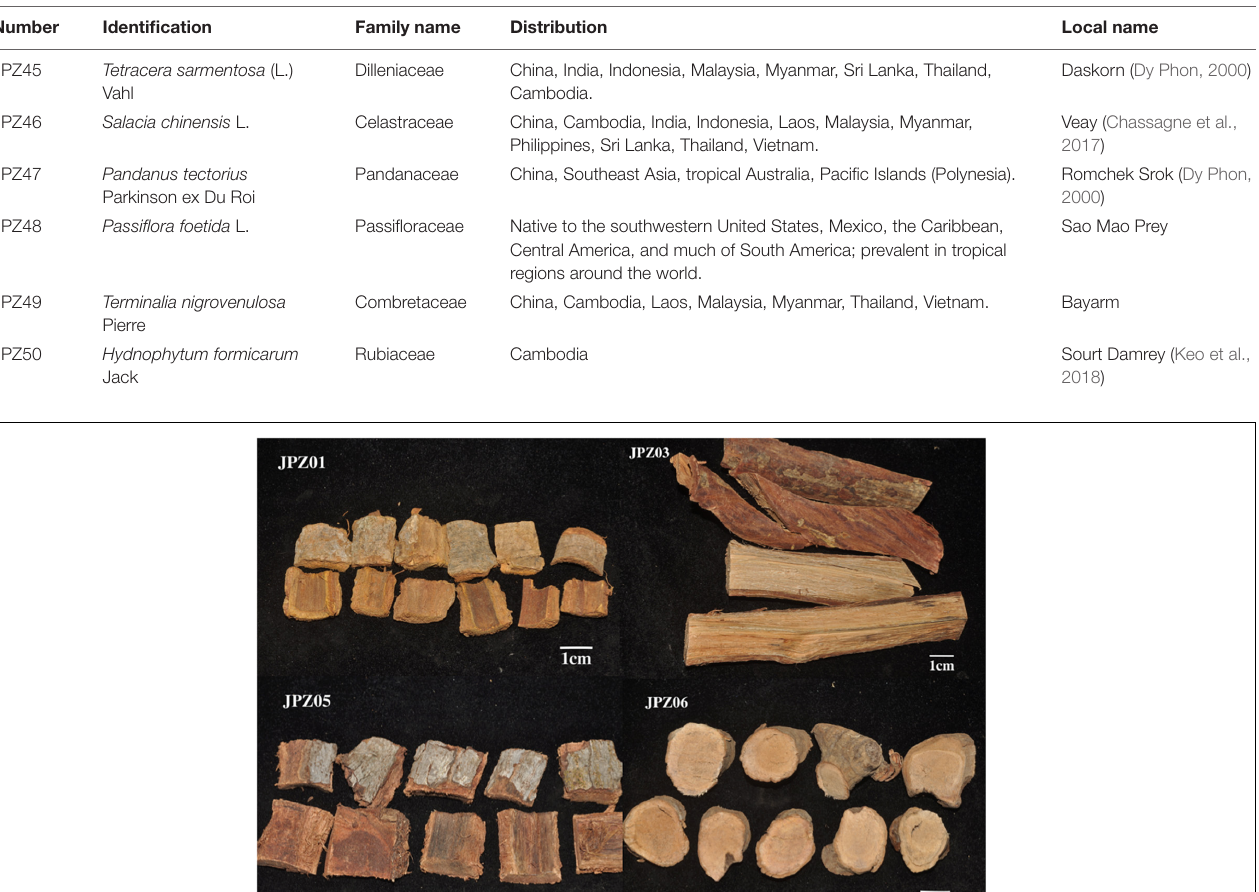
plants in Cambodia are similar to the three aforementioned provinces in